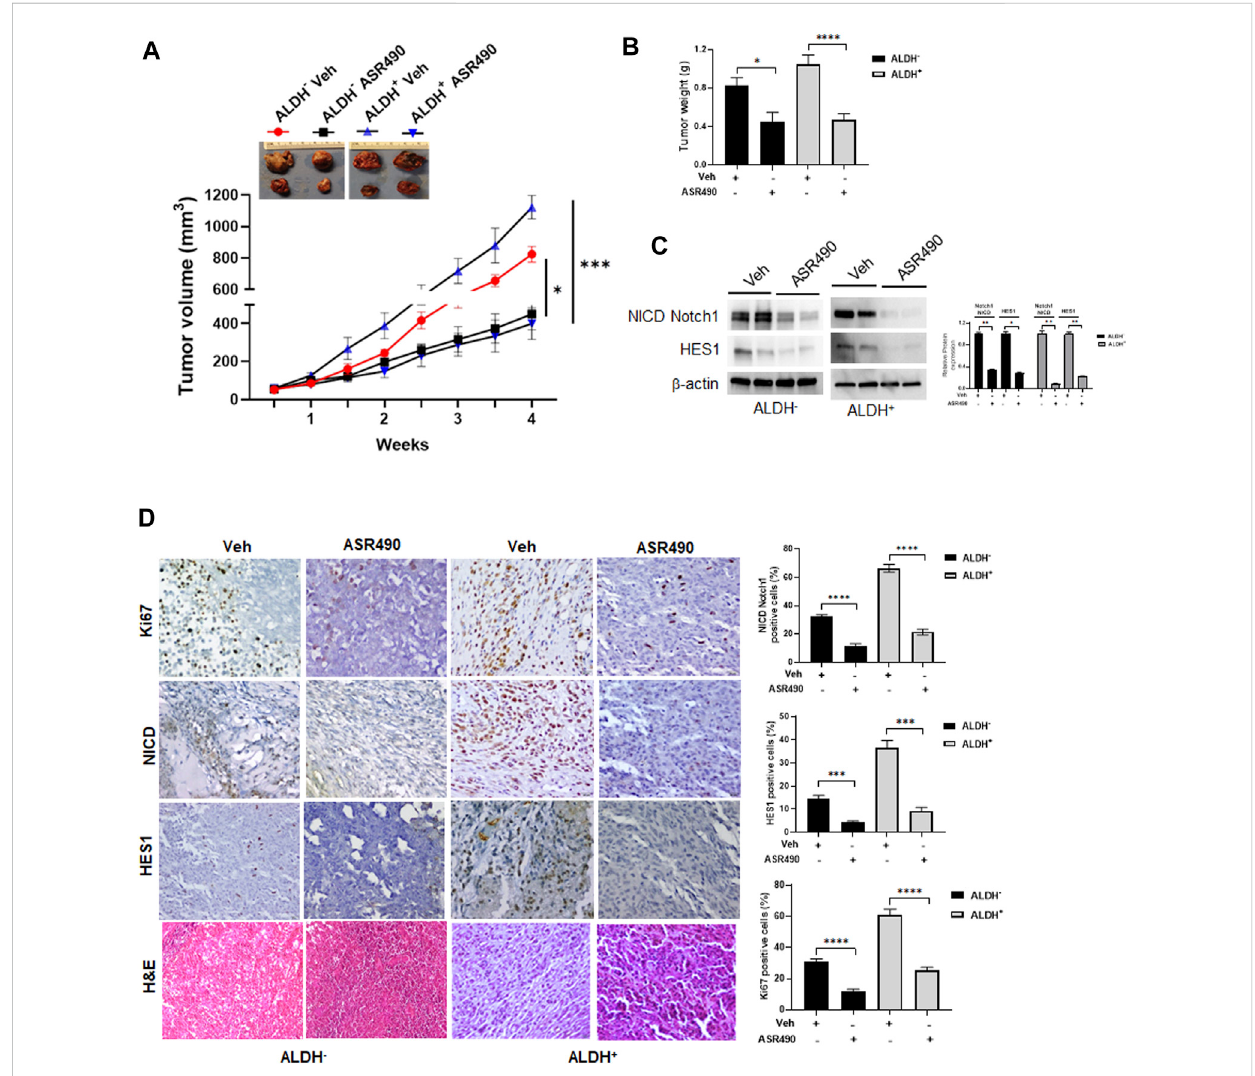
FIGURE 9 ASR490 reduces the tumor burden of xenotransplanted breast tumors. (A) Oral administration of ASR490 (25 mg/kg) signi fi cantly inhibited the growthofALDH − andALDH + xenotransplantedtumors( n =6,* p < 0.01,*** p < 0.001). (B) TumorweightofvehicleandASR490treatedALDH − andALDH + tumors. (C) Western blots performed for Notch1-NICD and HES1 on vehicle and ASR490-treated ALDH − and ALDH + tumors. (D) IHC analyses was performed on vehicle and ASR490-treated ALDH − and ALDH + tumors to evaluate the expressions of Notch1-NICD, HES1, and Ki67 (proliferation marker). p values were calculated using a two-sided Student ’ s